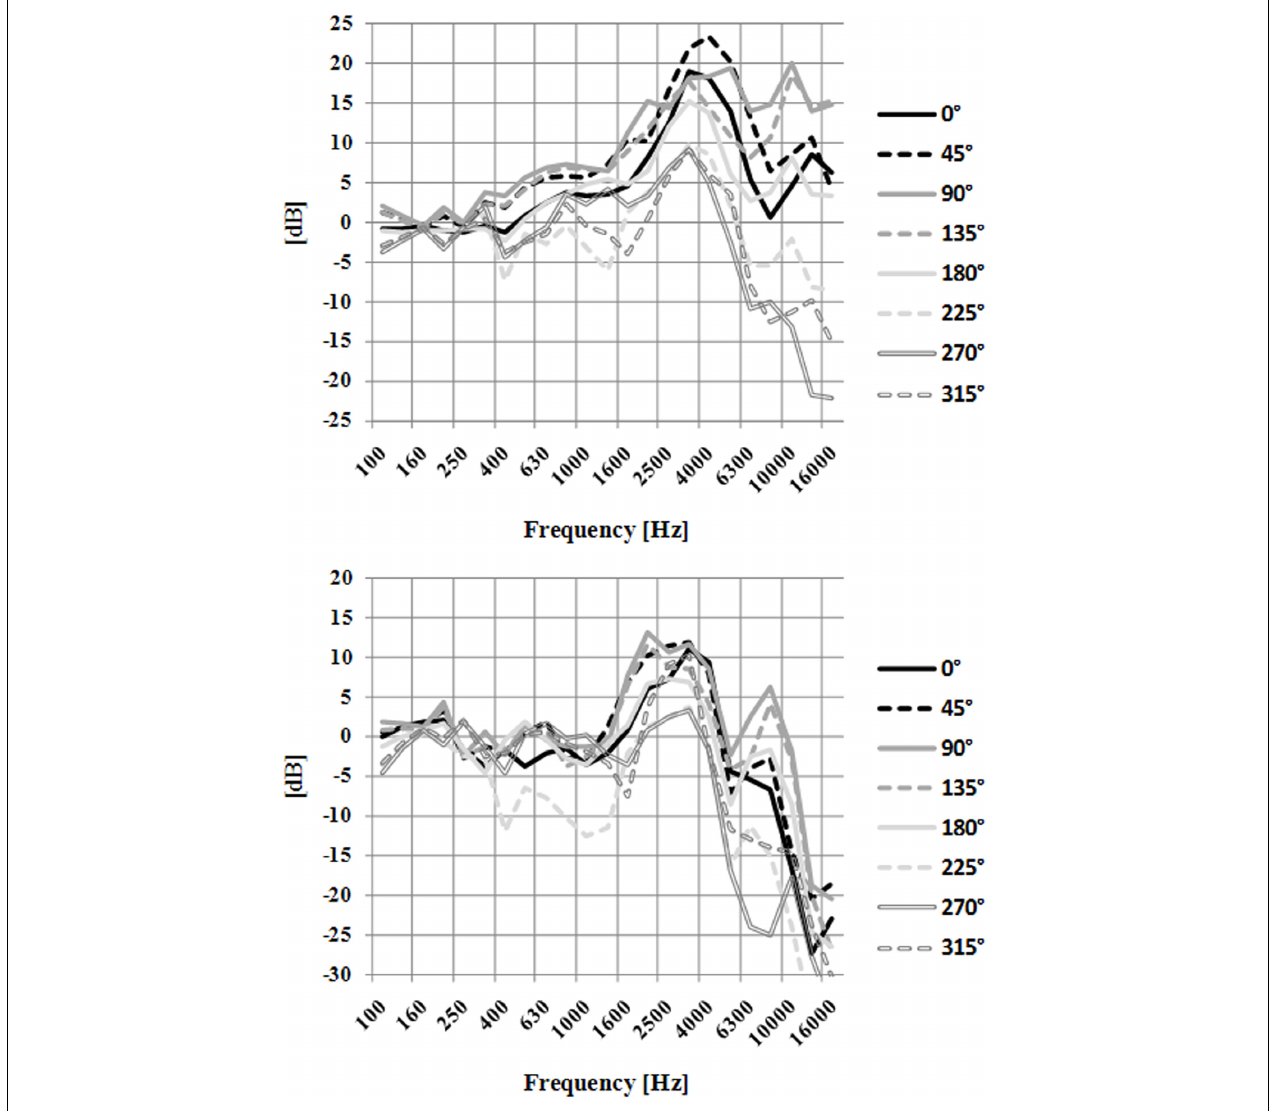
FIGURE 5 | HRTFs measured in the right ear, without an HPD in place at the top and with P5 in place at the bottom, for the eight orientations of the artificial head with respect to the noise source. Different types of lines correspond to different